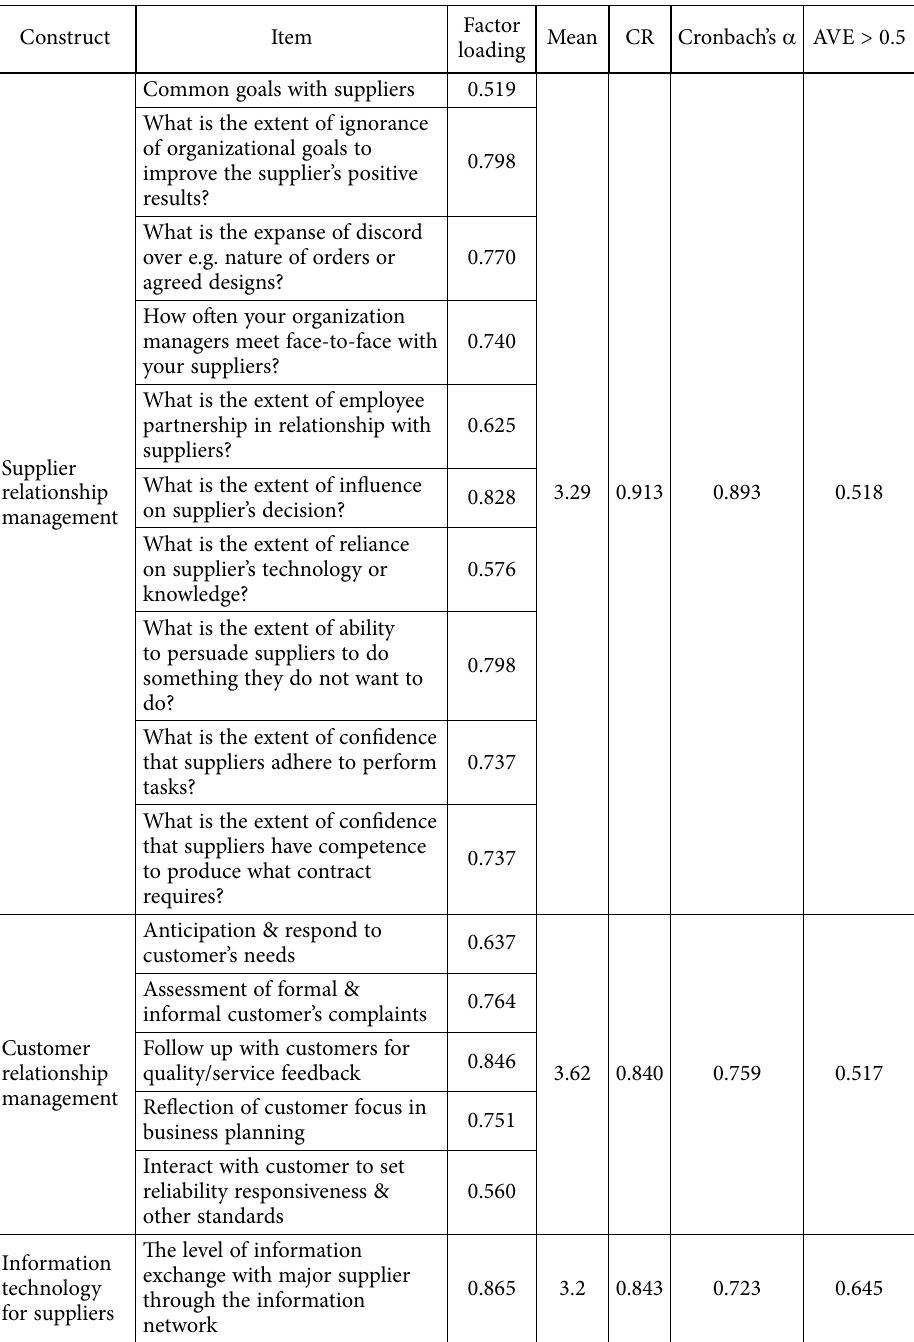
Table 2. Validity and reliability measures